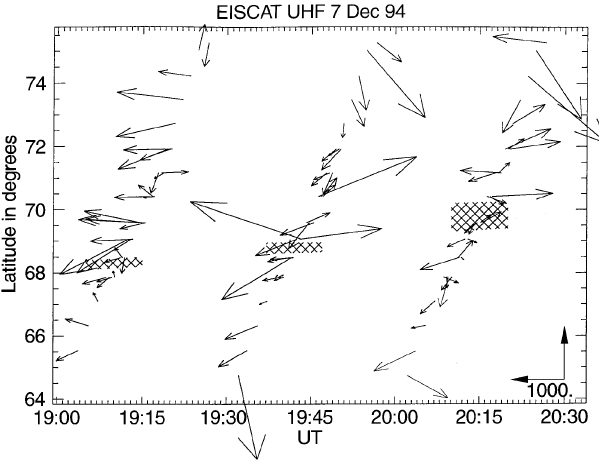
Fig. 7. 20-s-integrated plasma drift measurements by the EISCAT CP-3 programme. The location of the arc was traced up to the 275-km altitude of flow measurement and is marked during each scan. The scale for 1000 m s (cid:126)(cid:49) plasma drift velocity is given in the lower right corner. East is right